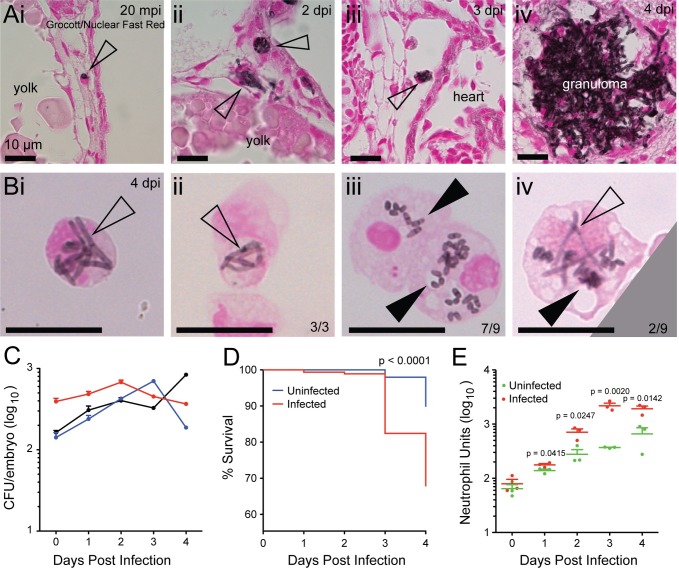
T. marneffei infection of zebrafish at 33°C.(Ai-iv) Histology of infected zebrafish embryos at different stages of T. marneffei infection. Sections were stained with Grocott methanamine silver to visualize fungi and counterstained with Nuclear Fast Red. Scale bar: 10 μm. (i) Phagocytosed conidium (arrowhead) within host leukocyte in the circulation at 20 minutes post infection. (ii) At 2 dpi, two fungal morphologies were observed: intracellular fungi assumed typical yeast morphology (upper arrowhead), while extracellular fungi displayed an elongated form (lower arrowhead). (iii) Yeast morphology of T. marneffei within a circulating infected leukocyte (arrowhead) at 3 dpi. (iv) Granuloma formation at 4 dpi. (B)FACS-purified, cytospun, T. marneffei-laden leukocytes prepared from infected embryos at 4 dpi, incubated at 33°C during infection. Grocott methanamine silver with Nuclear Fast Red counterstain. (i and ii) show neutrophils laden with hyphal forms (empty arrowheads), representative of all neutrophils observed. (iii) shows two macrophages laden with yeast forms (full arrowheads), the dominant morphology observed. (iv) shows a macrophage containing fungal cells of both yeast and hyphal morphologies. Scale bar: 10 μm. (C) Three representative CFU time-courses of infection at 33°C. In contrast to infections at 28°C (Fig 1D), no consistent decrease in CFU was observed at 4 dpi. Data are mean±SD of 3 independent replicates, n = 5 embryos (pooled)/timepoint/experiment. (D) Kaplan-Meier life table analysis for the treatment groups shown in (E). Significantly reduced survival occurred in infected groups compared to uninfected groups. n = 297 for uninfected, 319 for infected. P-value from Gerhan-Breslow-Wilcoxon Test. (E) Measurement of neutrophil populations during infection using Neutrophil Units. A significant increase in neutrophil population size occurred in the infected group compared to uninfected group over 1–4 dpi. Data are mean+SEM from 3 independent experiments. n = 5 embryos/group/timepoint in each experiment. P-values from unpaired two-tailed t-test.